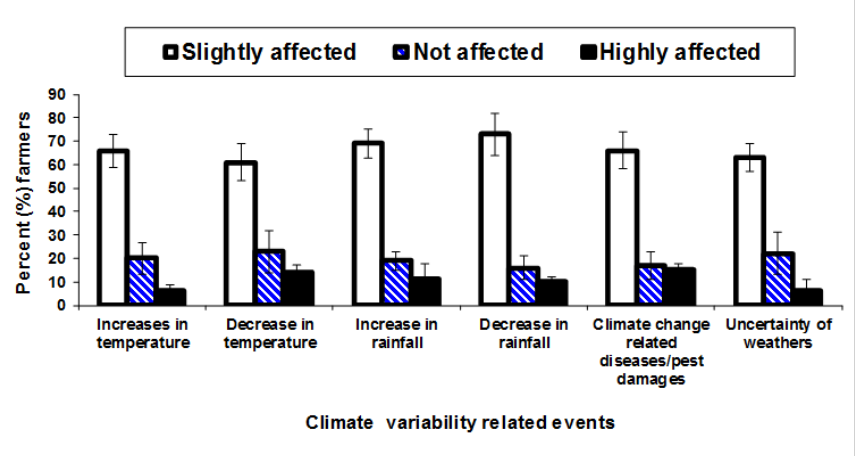
Figure 3a. Do the climate change related common natural hazards and catastrophes (floods, drought, heavy precipitation, winds) affects